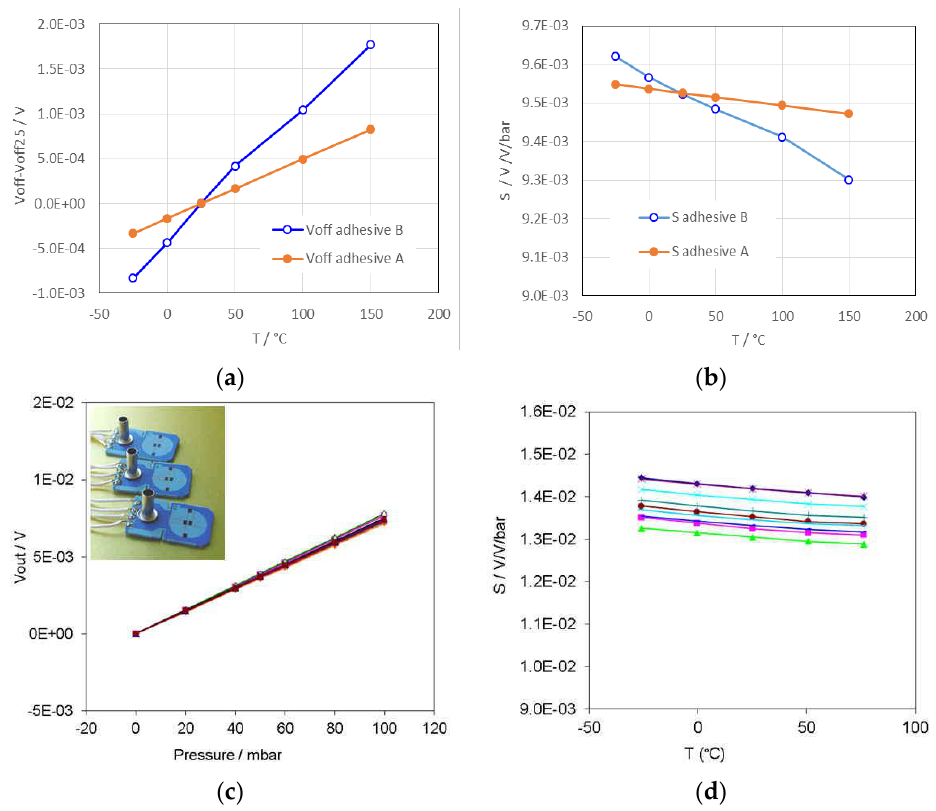
Figure 8. Predicted temperature characteristics of the 100-mbar sensor: ( a ) offset voltage at V s of 5 V; ( b ) sensitivity (S). Measured characteristics of 100-mbar sensors with the tubes manufactured in our previous work: ( c ) Sensors output voltage ( V out ), ( d ) temperature dependence of sensitivity (S).